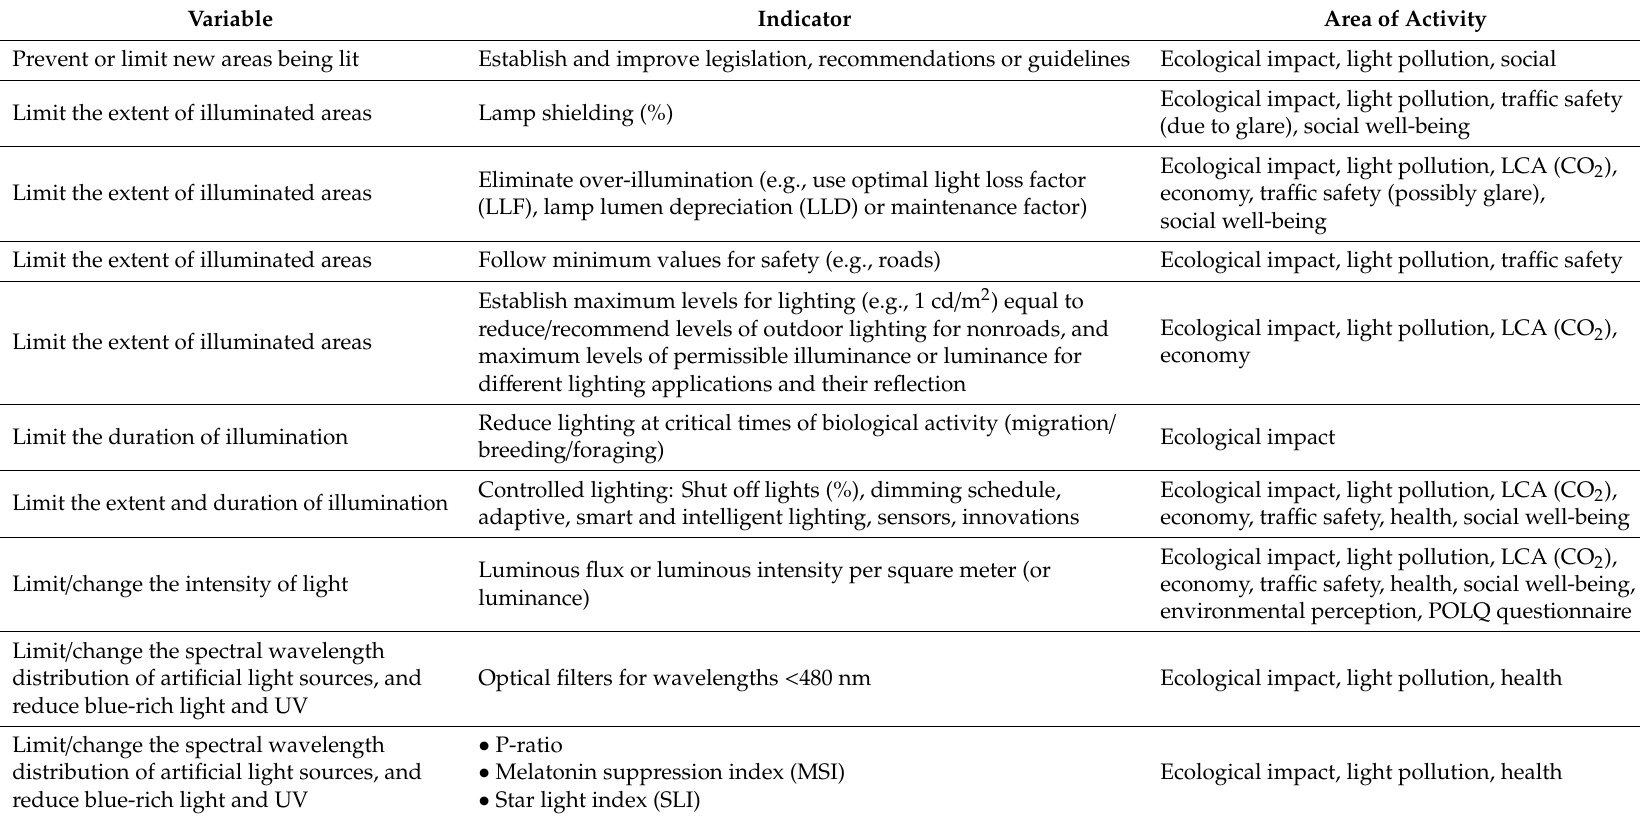
Table A1. Indicators and variables of sustainable development in the ecological and environmental dimension and area of